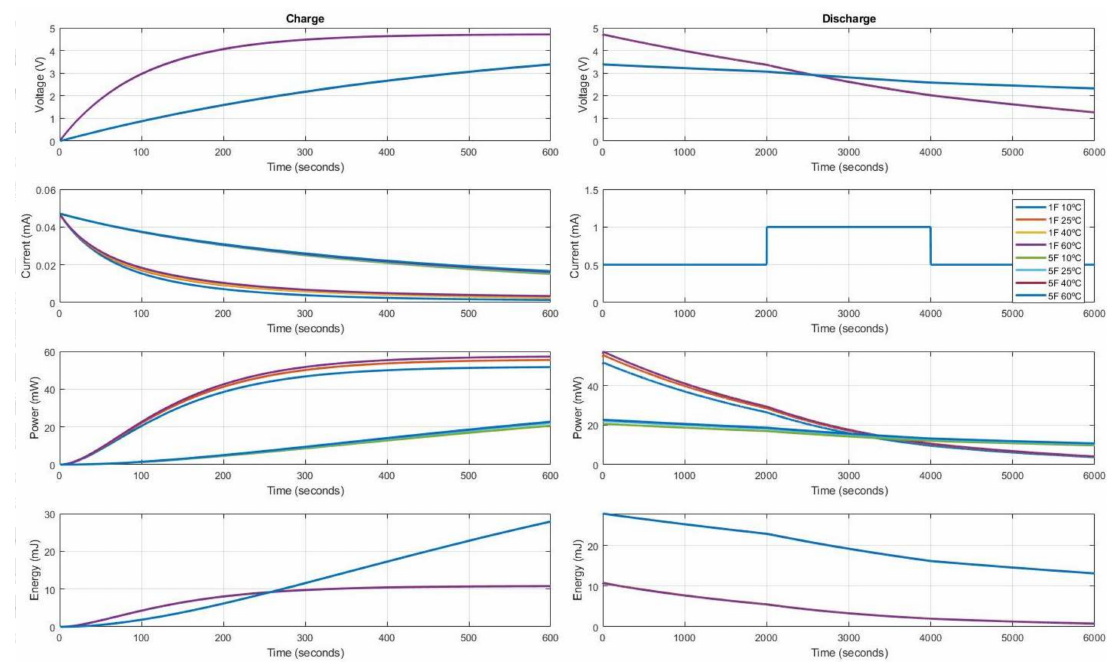
Figure 8. Charge and discharge results obtained with the mathematical model for 1 F and 5 F supercapacitor values at different temperatures (10, 25, 40 and 60 ◦ C), 600 s charge with 5 V and same outer profile consumption composed by three steps; First step 0.5 mA for 2000 s, second step 1 mA during also 2000 s and third step as first